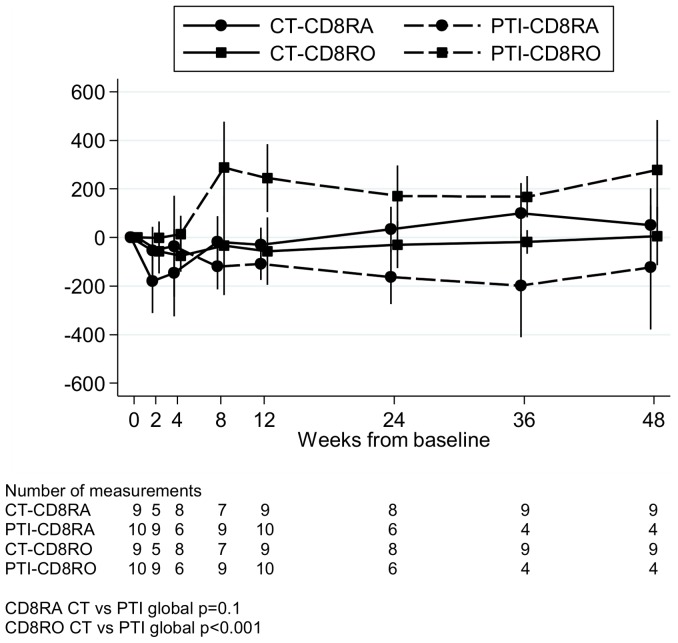
Change in CD8 RA and RO cells from baseline.Change in CD8 RA and RO cells from baseline for children in the substudy. CT = continuous ART (antiretroviral therapy), PTI = planned treatment interruption (off ART). Changes from baseline were estimated using normal regression of actual measurements adjusting for baseline using the overall mean at randomisation as the reference category.